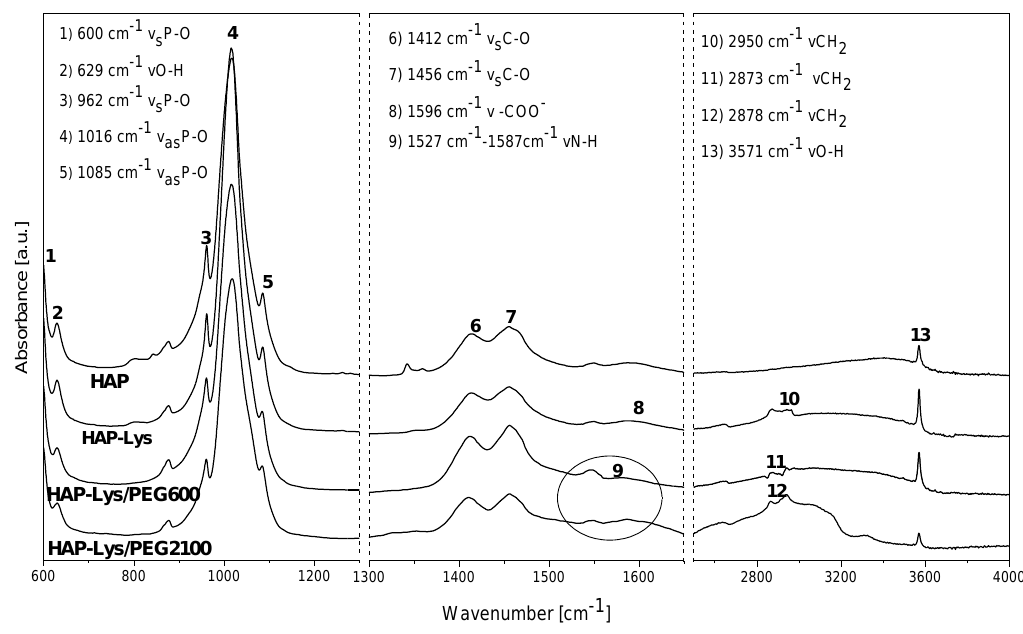
Figure 1. The attenuated total reflectance-Fourier transform infrared (FTIR-ATR) spectra of unmodified hydroxyapatite (HAP), HAP modified with L -lysine, and HAP after polyethylene glycol (PEG) grafting.